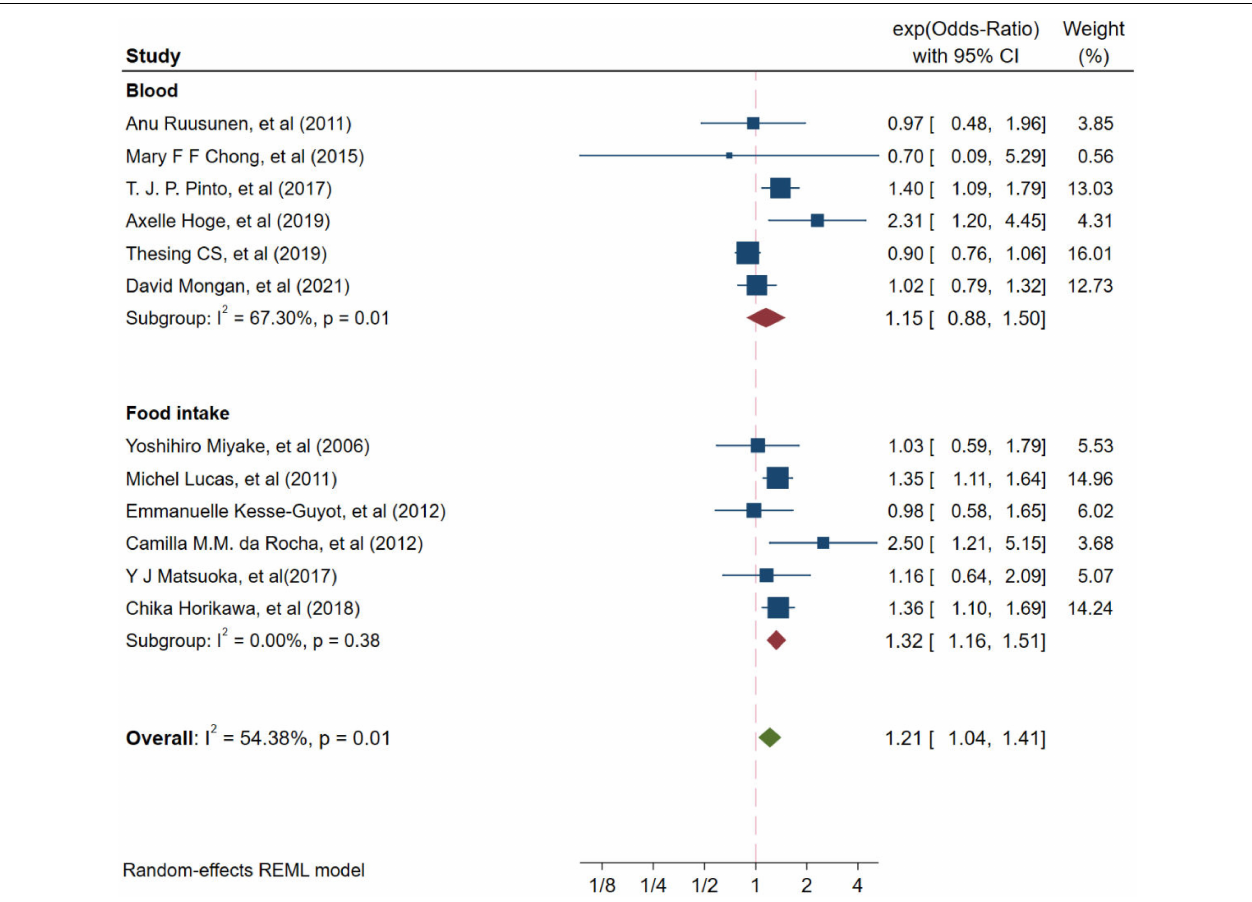
FIGURE 3 | Odds ratios of depression for highest vs. lowest category of ratio of n-6/n-3 PUFAs from different resources. Overall odds ratios calculated with random effects